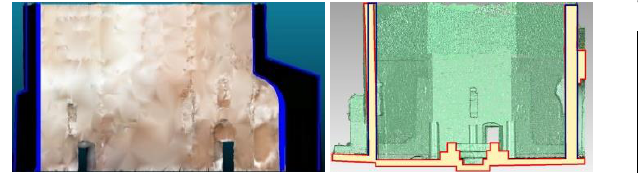
Figure 16. First bending mode along x direction with the overlap of deformed and undeformed shape. Current model (left) and geometrical model (right)